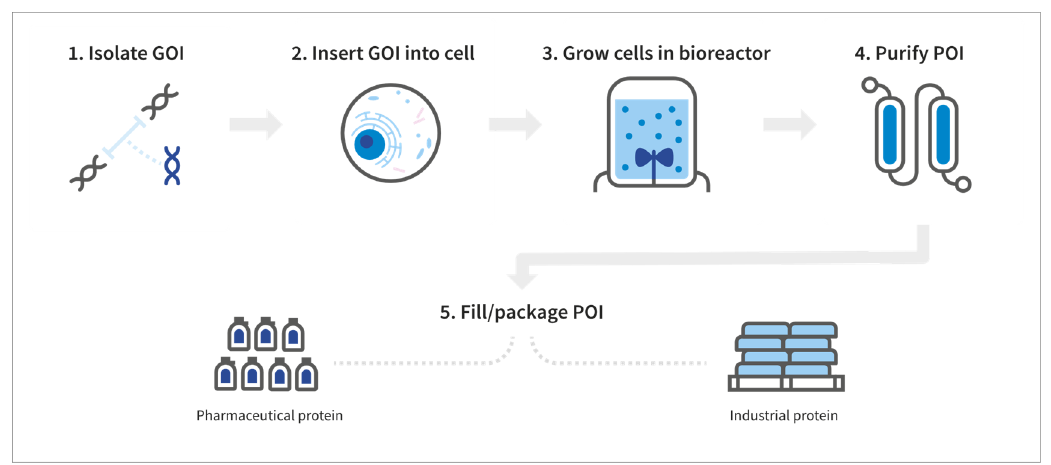
Figure 1. From gene of interest to protein of interest—a simplified scheme.